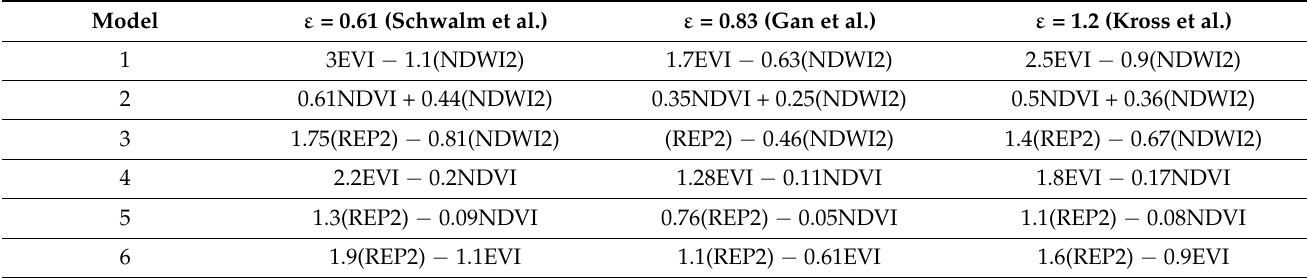
Figure 3. The correlation matrix of modelled GPP with EC-derived GPP for 2018 (red represents stronger positive correlation, blue and yellow represent moderate positive correlation, and grey color shows correlation below 80%). Table 3. Multiple-regression-based hybrid models.